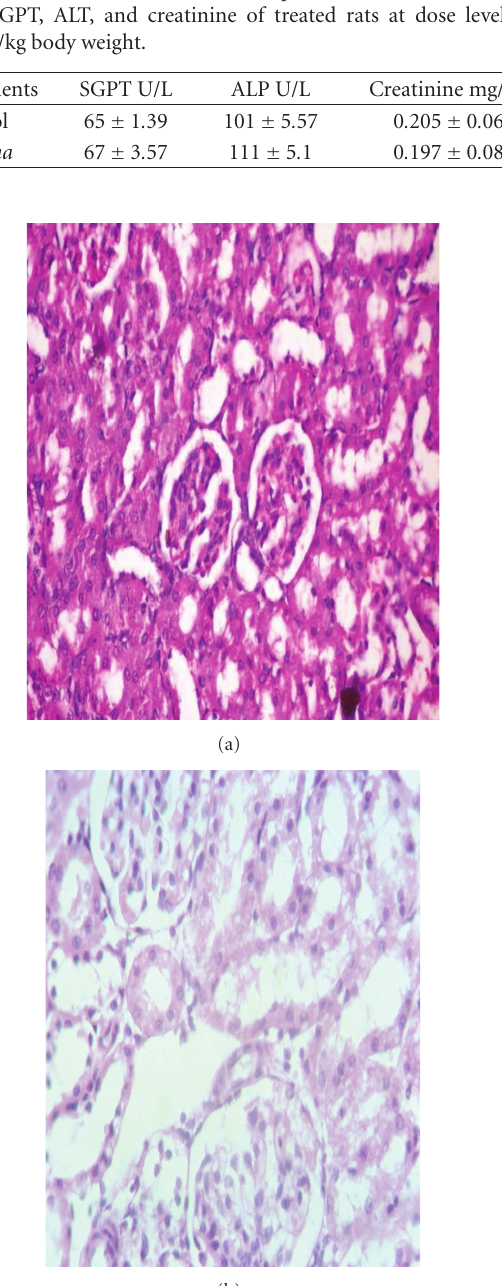
Figure 1: Sections in kidney of rats treated with C. senna extract (b) at dose level of 500 mg/kg after 21 days of treatment relative to control (a).